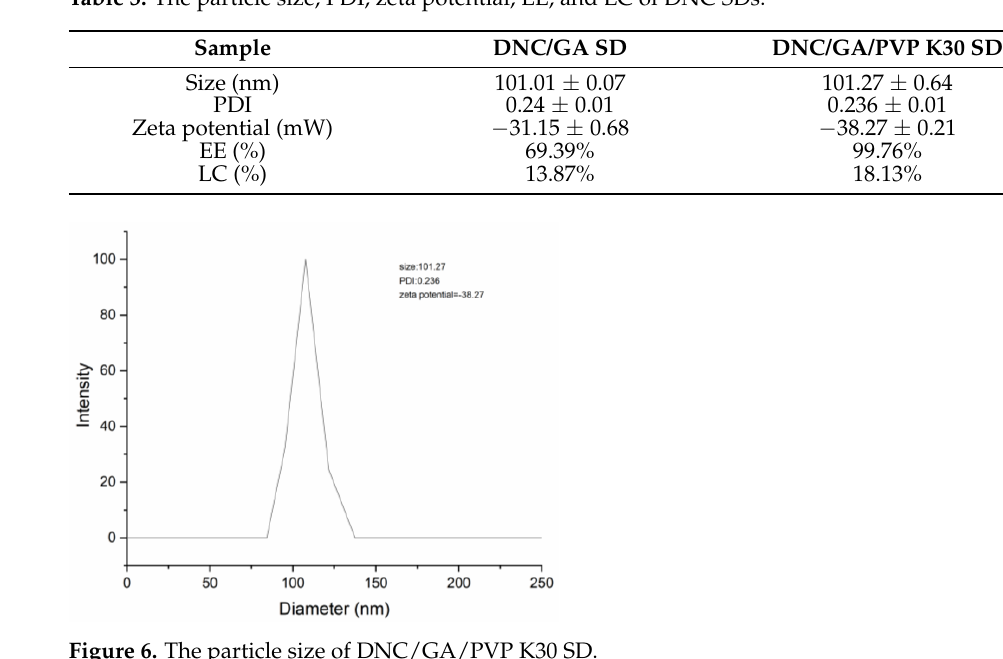
Table 3. The particle size, PDI, zeta potential, EE, and LC of DNC SDs.